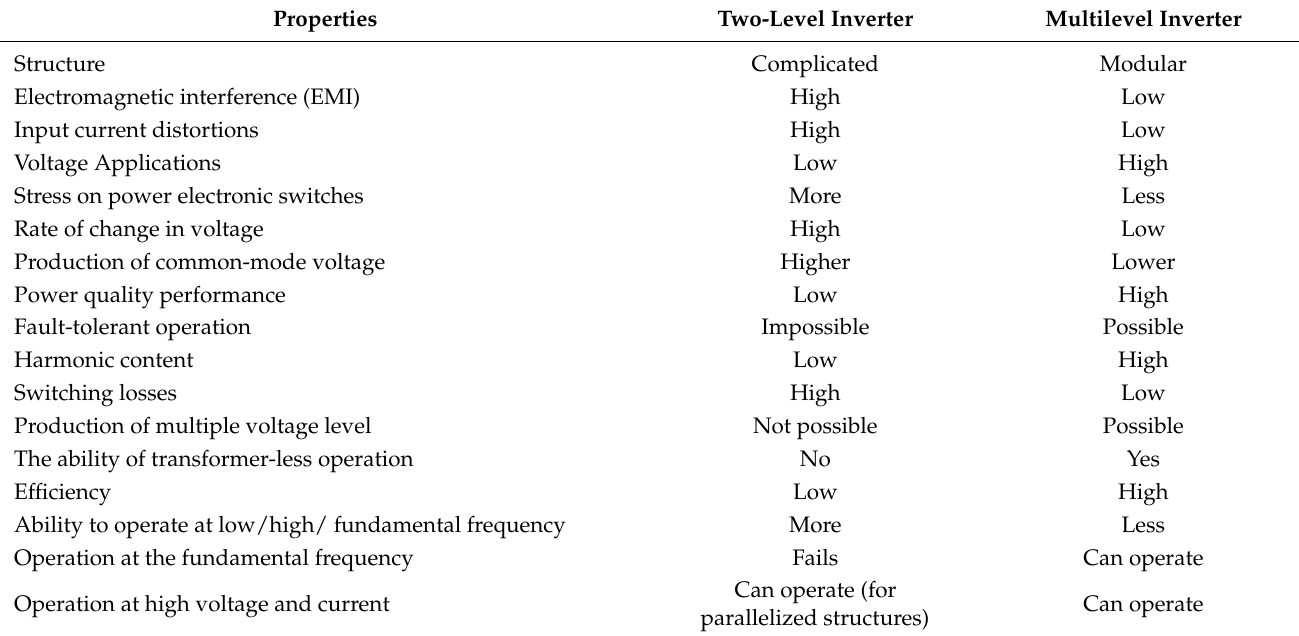
Table 1. Difference Between Two-Level Additionally, Multilevel